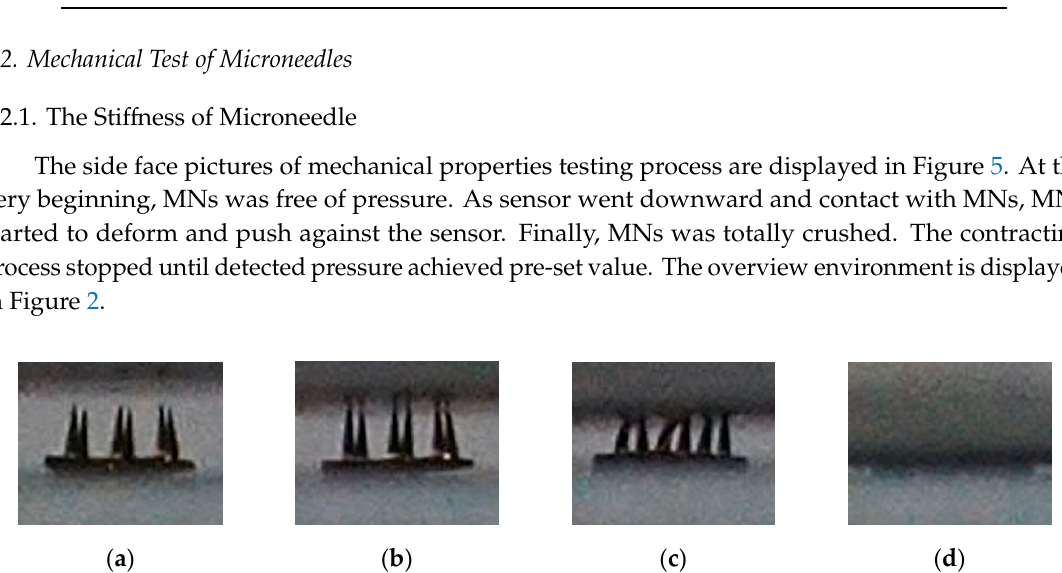
( a ) ( b ) Figure 6. The mechanical properties of MNs with different exposure time: ( a ) the pressure-displacement curves of MNs with different exposure time; ( b ) the K of MNs with different exposure time. 3.2.2. Penetration of Artificial Skin